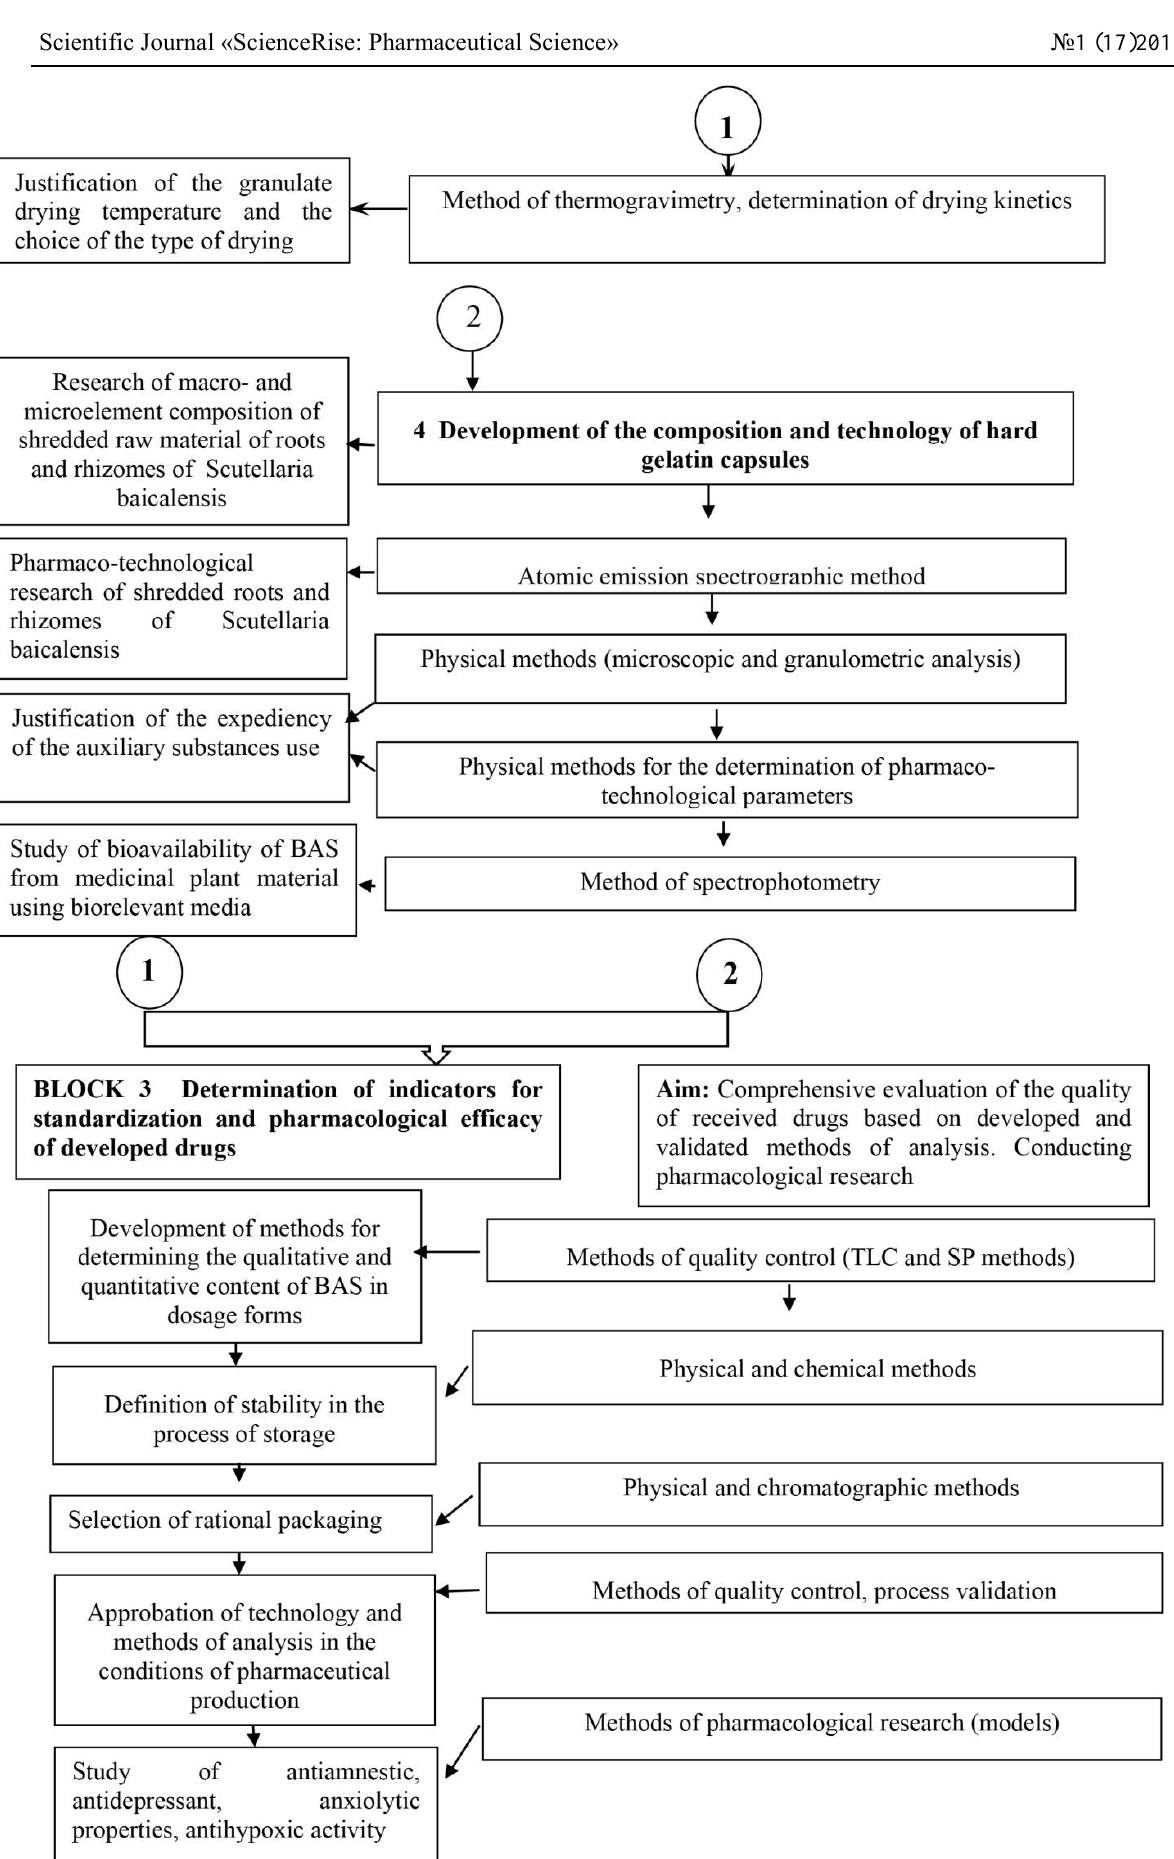
Fig. 2. Methodological approach to the creation of drugs with nootropic action on the basis of plant